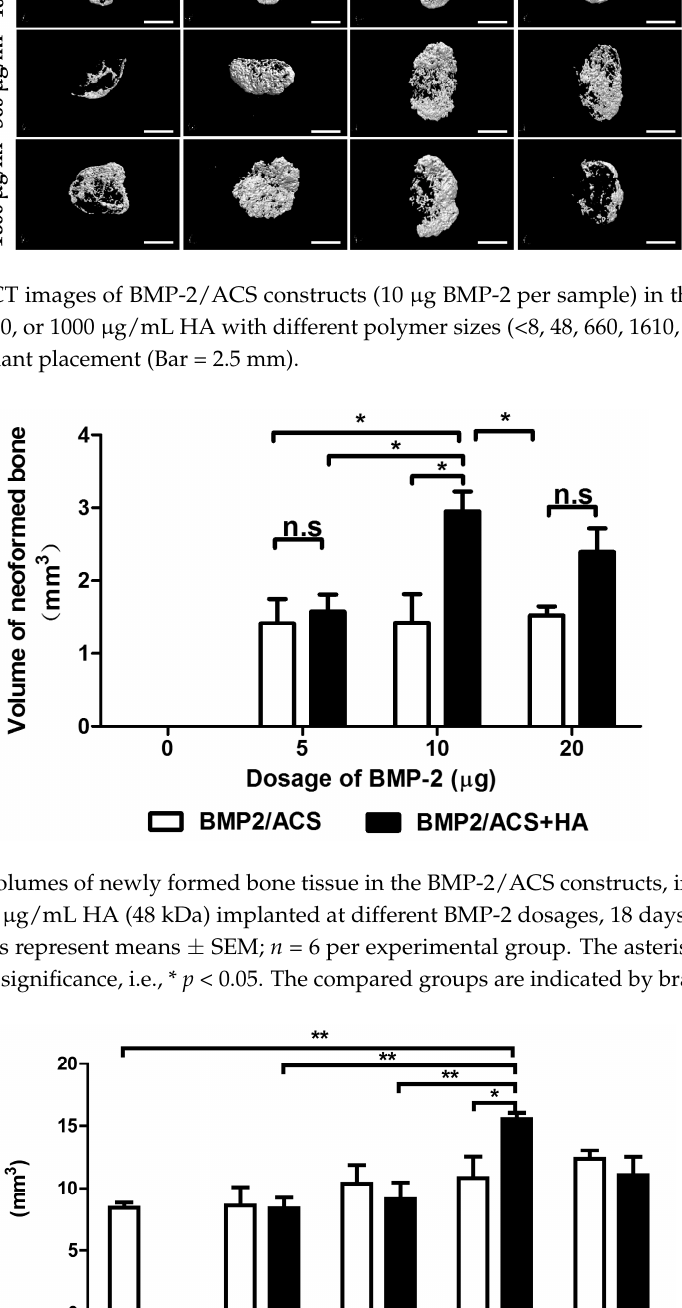
Figure 3. Mean volumes of total construct volumes of the BMP-2/ACS constructs, in the presence or absence of 100 µ g/mL HA (48 kDa) implanted at different BMP-2 dosages; 18 days after implant placement. Values represent means ± SEM; n = 6 per experimental group. The asterisks denote the level of statistical significance, i.e., * p < 0.05, ** p < 0.01, *** p < 0.001). The compared groups are indicated by brackets.